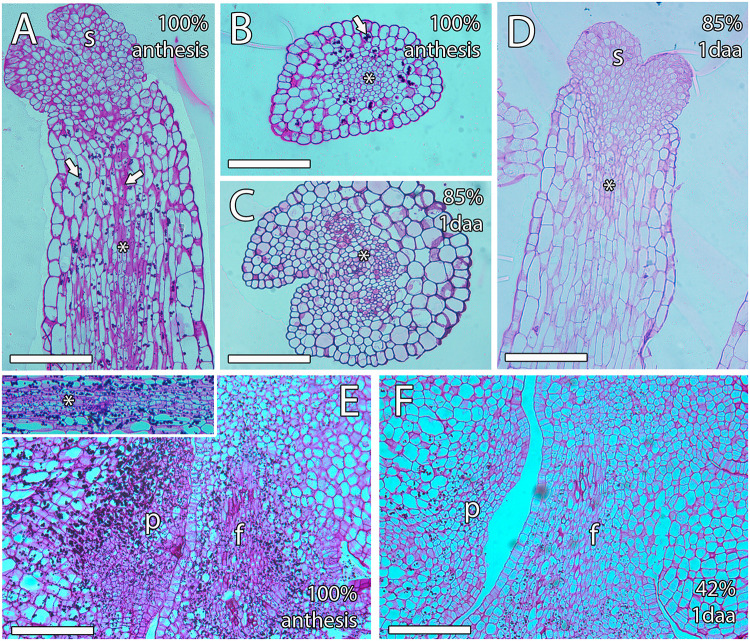
Starch grains along the transmitting tissue of mango pistils. (A,B) Longitudinal (A) and transversal (B) sections of the style at anthesis showing big starch grains (arrow) around the stylar transmitting tissue (asterisk), which contains smaller starch grains (arrow). (C,D) Transversal (C) and longitudinal (D) sections of the style 1 day after anthesis showing a small amount of starch grains. The asterisk indicates the stylar transmitting tissue. (E) The ponticulus is full of starch grains at anthesis. The upper square shows starch grains in the transmitting tissue (asterisk) in the proximity of the ponticulus at anthesis. (F) The ponticulus contains less starch grains 1 day after anthesis. S, stigma; P, ponticulus; F, funiculus. Scale bars, 100 μm.